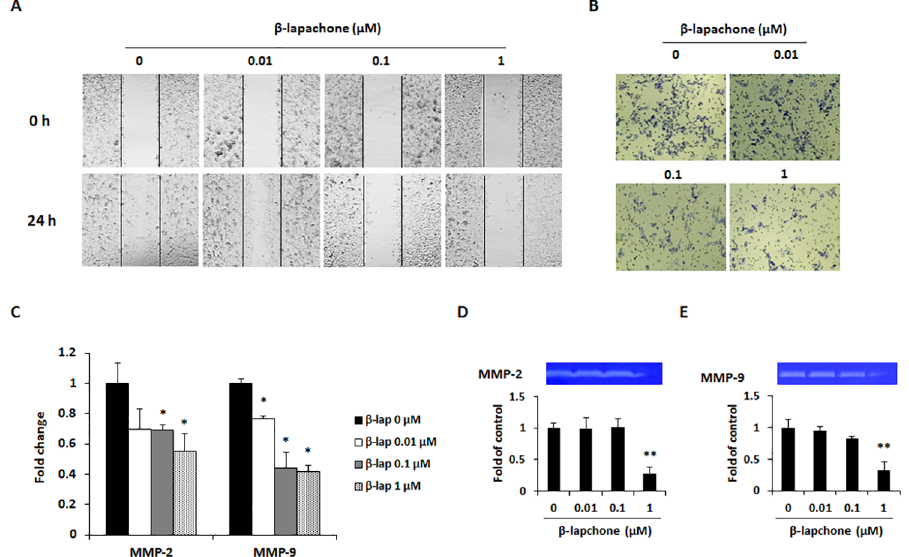
Fig 6. Effect of β -lapachone on the migration and invasion of B16F10 cells, through inhibition of MMP expression and activity. (A) Cancer cell motility was determined by woundhealingassay. Cells were culturedto 8–90% confluentmonolayerin a 6-well plate and scratched with a 200 μ l micropipet tip. After washingwith a serum-free medium, the cells were treated for 24 h with the indicatedconcentrations of β - lapachone. The denuded zone was observedat 0 and 24 h and images were photographed using a microscope (100 × magnification). (B) Invasionability of B16F10cells was determined by invasionassay using matrigel-coated transwellchamber. (C) The mRNA expressionlevels of MMP-2 and MMP-9 were measured by real-time RT-PCR after β -lapachonetreatment for 24 h. (D) Inhibitory effect of β -lapachoneon activity of MMP-2 and MMP-9. After 12 h starvation, cells were treated with β -lapachone for 24 h and conditioned medium was collectedfor use in gelatinzymography.Photographs are representative of three independent experiments. The band intensity was quantitatively analyzedusing ImageJ software. Values are the means ± SD of data from three independentexperiments. * P < 0.05 and ** P <